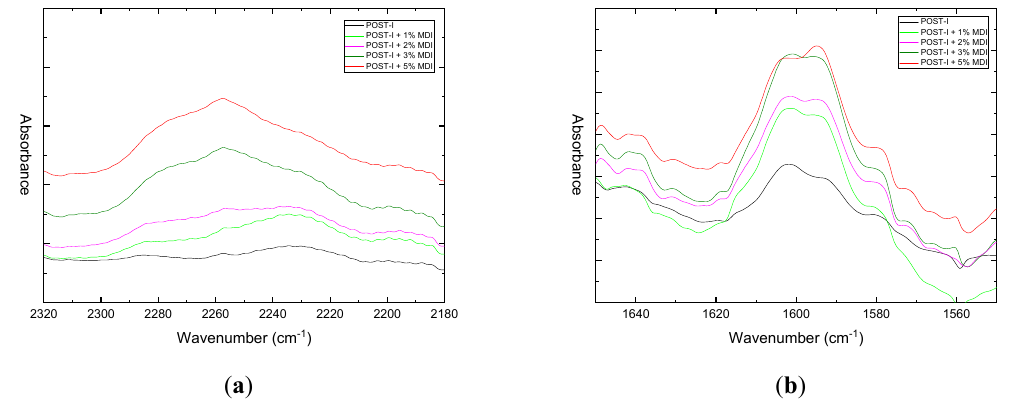
Figure 9. Comparison of FTIR spectra of blends without compatibilizers and with different levels of pure MDI content (1–5 wt %): ( a ) in the region of 2320–2180 cm − 1 ; ( b ) in the region of 1650–1550 cm − 1 .